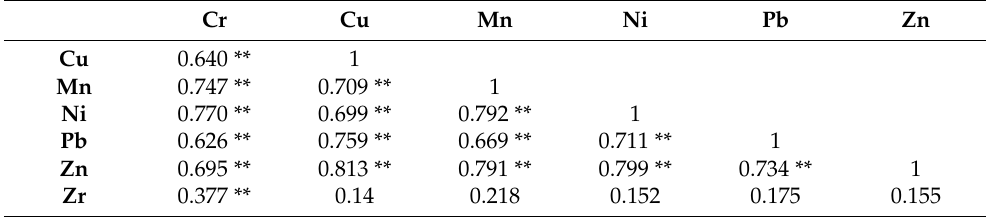
Table 3. Spearman correlation between the selected PTEs of the soil